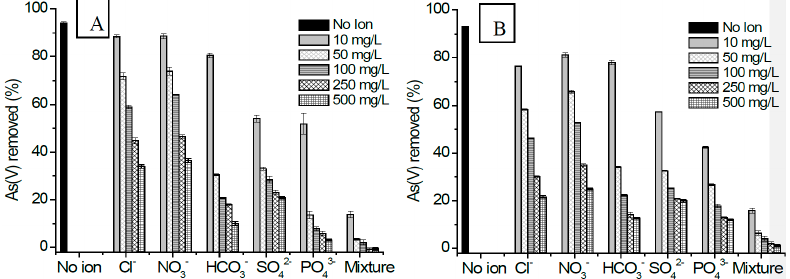
Figure 11. Effect of co-existing anions on As(V) removal by ( A ) Ch–Rs ( B ) Ch–Pu blends (initial concentration 0.25 mg/L, dose 8 g/L, shaking at 200 rpm for 2 h, at 24 ± 1 °C).